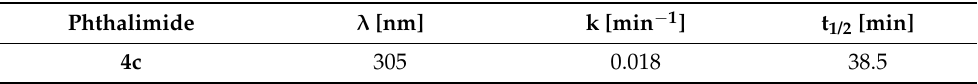
Figure 3. The changes in absorbance spectra of compound 4c during spontaneous hydrolysis. Spec- trum was monitored for 250 min with 10 min intervals in 0.05 M phosphate buffer (pH 7.3, 25 °C). Table 5. Half-life (t1/2) for the spontaneous hydrolysis of selected compound 4c